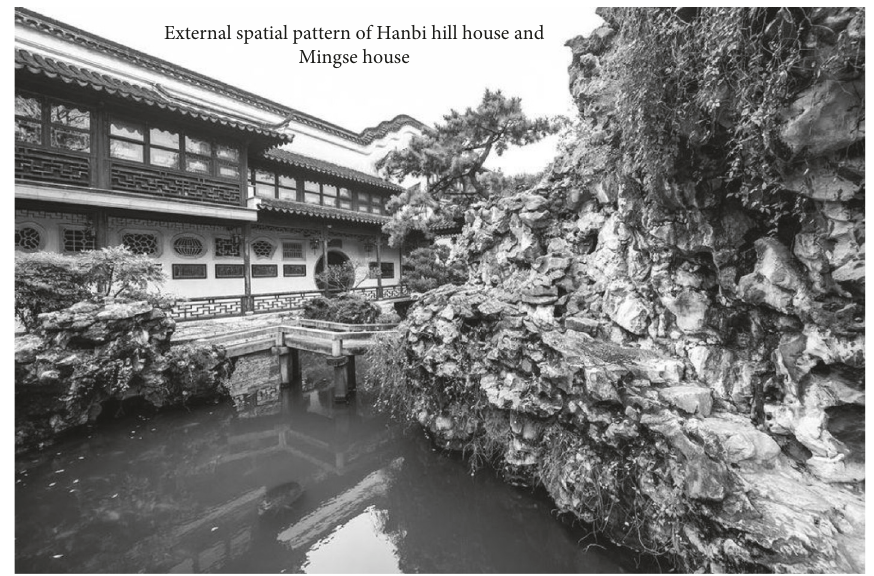
Figure 2: External spatial pattern of the Hanbishan house and Mingse